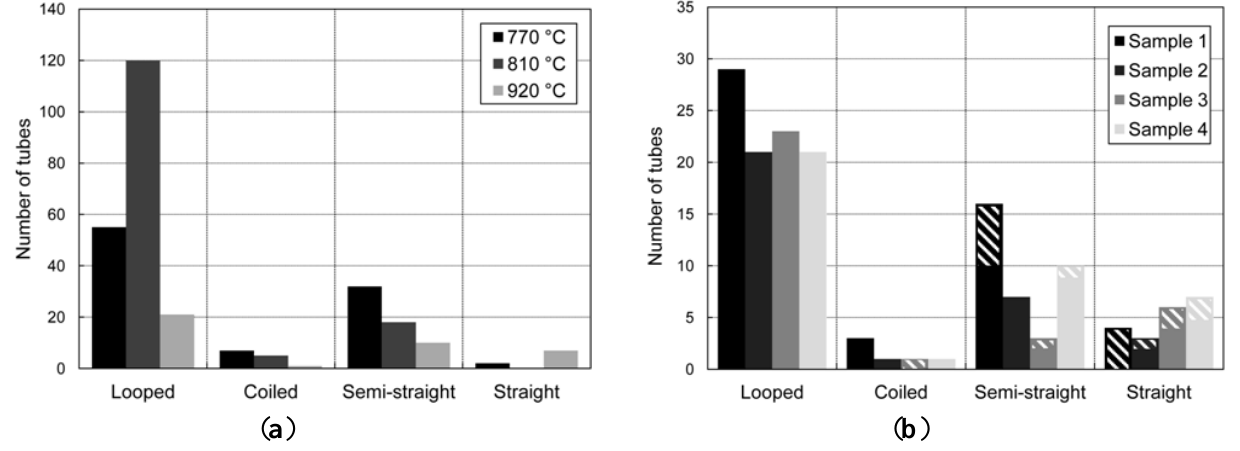
Figure 5. Number of CNTs, in different categories, growing in the gap between the primary and secondary bridge. ( a ) Samples grown at different temperatures; ( b ) samples grown at similar temperatures. In ( b ), the hatched regions represent the number of tubes that connected to the secondary